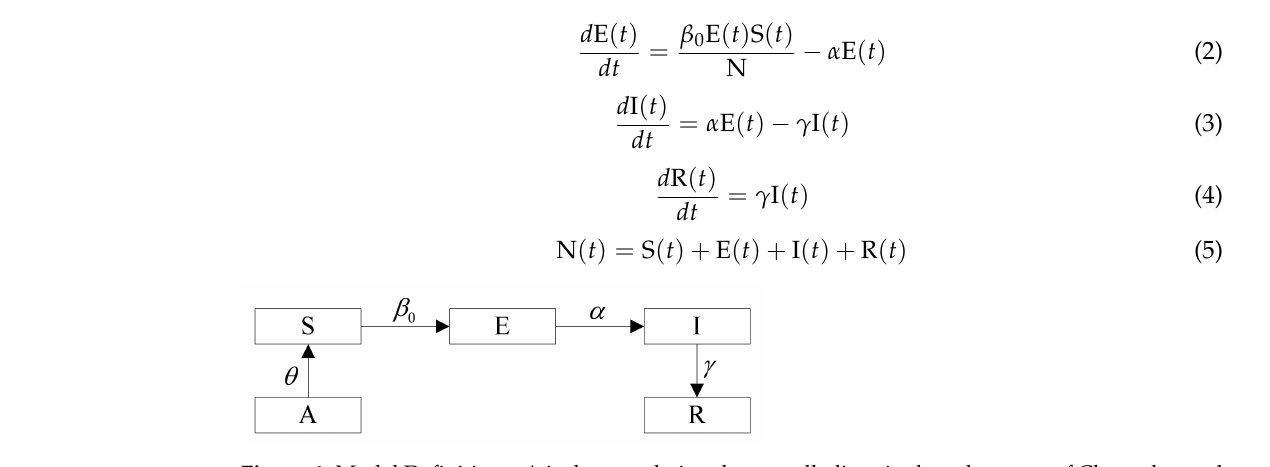
Figure 4. Model Definitions. A is the population that usually lives in the urban area of Changsha, and the proportion of the active population in the urban area is θ . This population constitutes S. Due to COVID-19 having an exposed period, S has a β probability of being converted to E after contact with population E. In E, there is a α probability of being converted to I by nucleic acid detection. Traffic control policies can cut off the contact between S and E, which in turn reduces the infection rate of E. All parameters are explained in Table 3. Table 3. Explanation of connotations of all